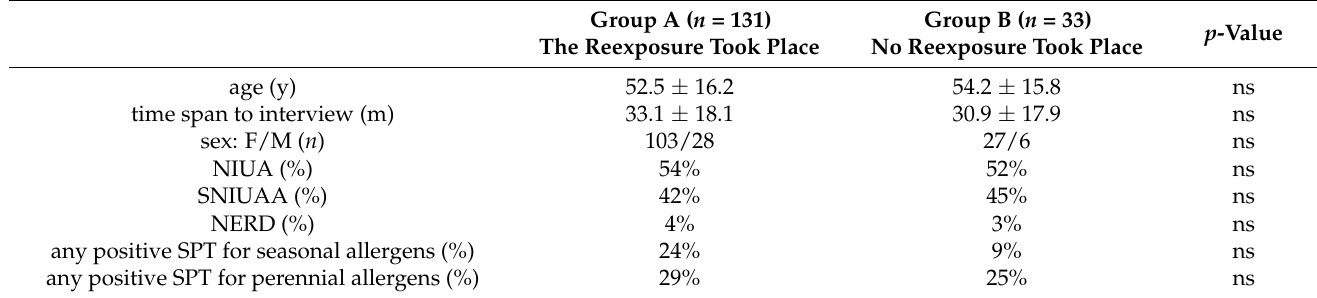
Table 3. Comparison of group A with group B in terms of clinical and demographic